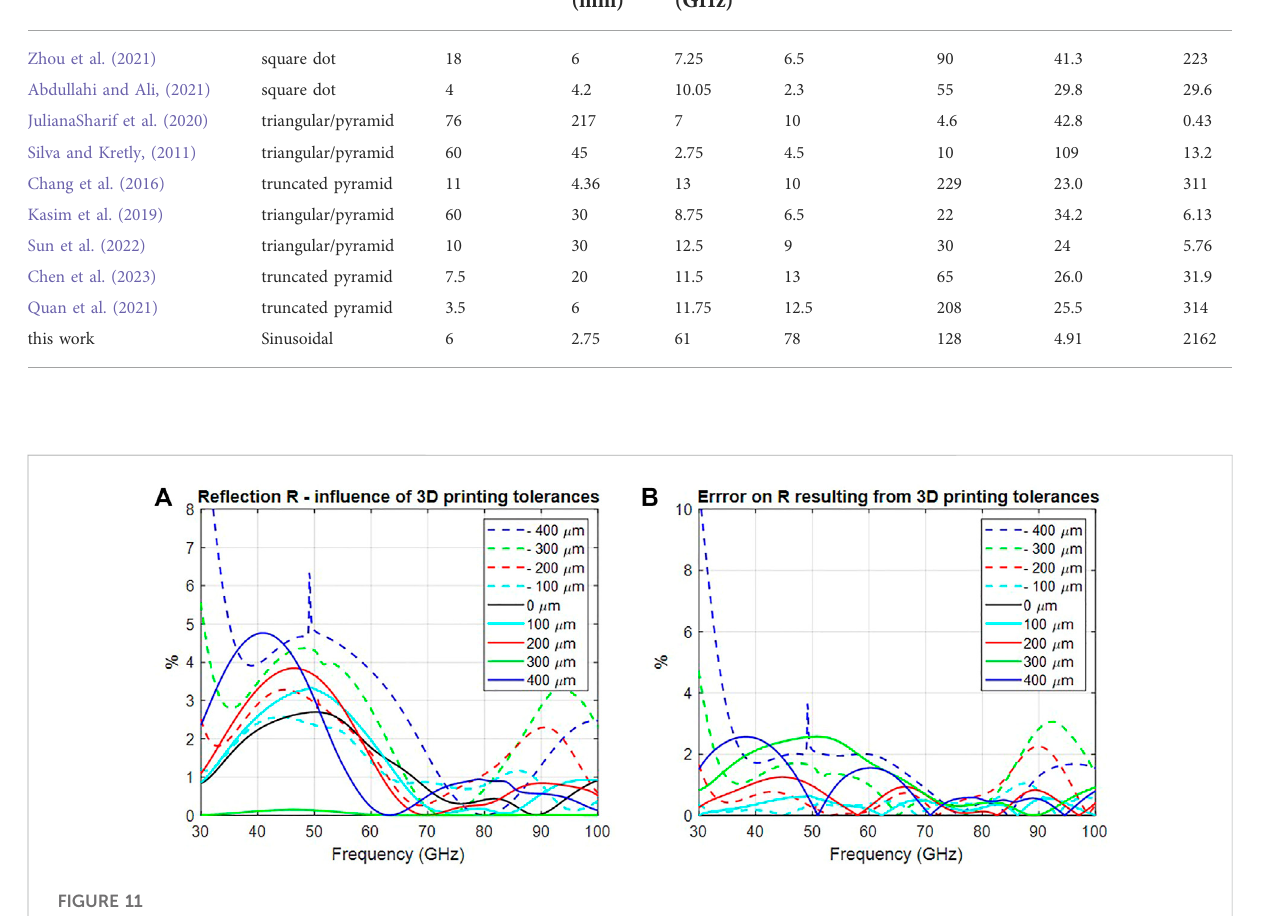
TABLE 5 Geometry, bandwidth and FOM performances for the various pro fi les from the literature. Ref.